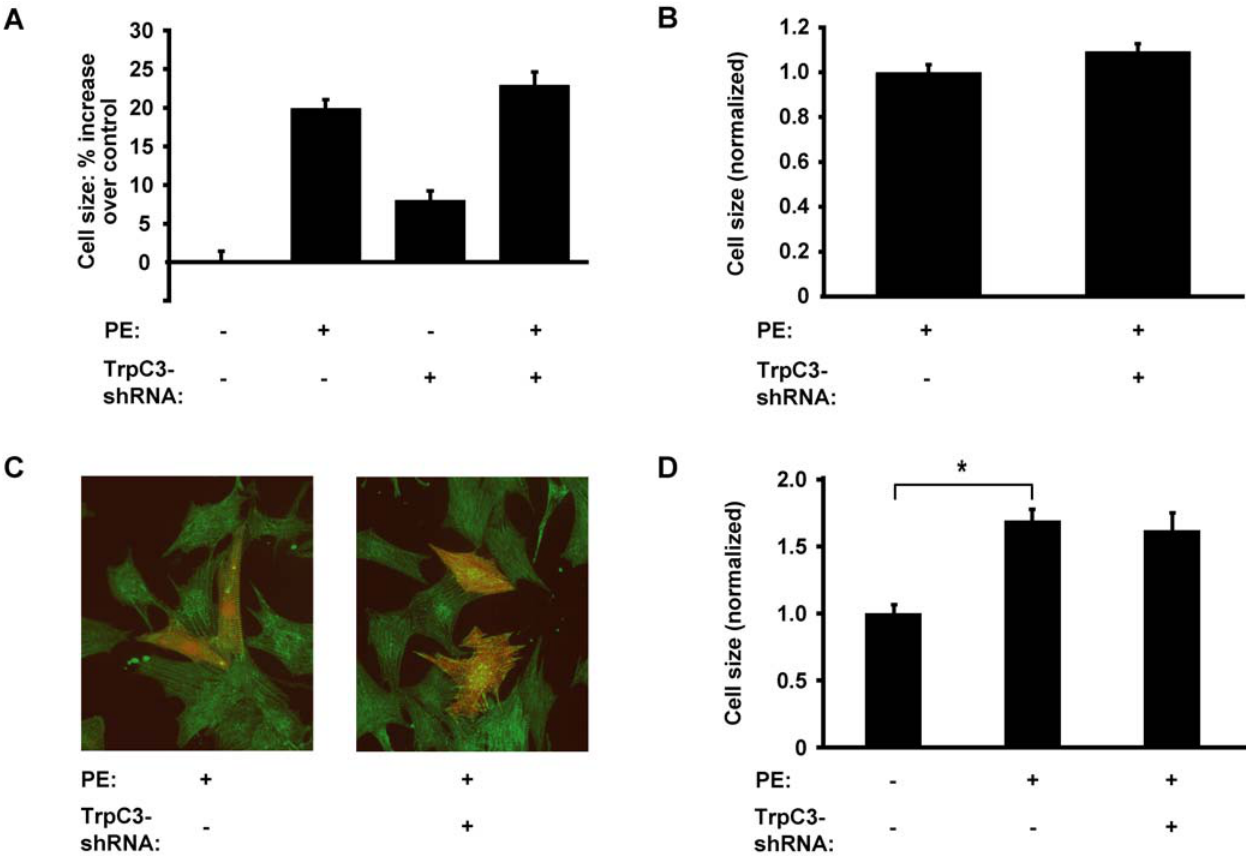
Figure 4. Reduction of TrpC3 does not prevent the increase in cell size associated with hypertrophy. ( A ) Cell size measurement of ventricular myocytes expressing either TrpC3 or a negative control shRNA and stimulated with 20 m M PE for 48 hours. Size is shown as percent increase compared to the size of unstimulated myocytes expressing negative control shRNA (the left column ). Cell size was measured using an automated fluorescence microscope and analysis program. For each condition, n . 1000 transfected myocytes analyzed. Columns 2–4 were each significantly different than column 1 , P , 0.001. Columns 2 and 4 (PE-stimulated myocytes expressing negative control shRNA or TrpC3-shRNA, respectively) are not significantly different from each other. ( B ) The results in A were confirmed by using manual-measurements of myocyte cell size in cells stimulated with 20 m M PE for 60 hours. Cells expressing TrpC3-shRNA were not significantly different in size than those expressing LacZ-shRNA. n=125 cells per condition. ( C ) Examples of myocytes expressing negative control shRNA (left) and TrpC3-shRNA (right) used in the manual measurement of cell size. Myocytes were stained with anti- a -actinin antibody (green), and cells that were expressing shRNAs are red. ( D ) Myocytes expressing LacZ- or TrpC3- shRNAs were stimulated with 20 m M PE for 60 hours and then fixed, immunostained with anti-ANP antibody, and measured simultaneously for cell size and ANP-immunofluorescence. TrpC3-shRNA had no effect on cell size ( columns 2 and 3 ), but significantly decreased ANP expression (data displayed in Fig. 2 F ). Average n=31 cells per condition. * indicates statistically significant difference compared to control, P , 0.0001. For all bar graphs, data are represented as mean 6 SEM.